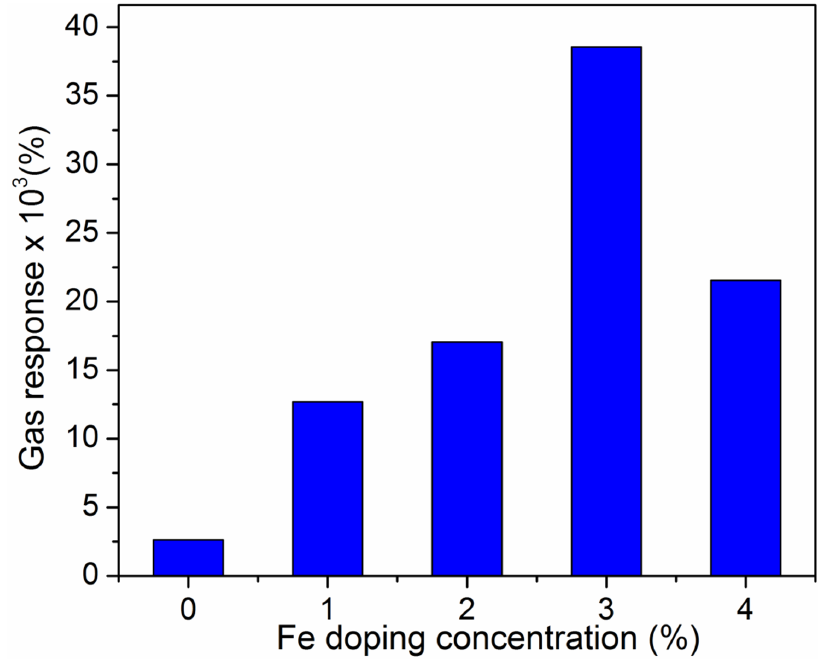
Figure 7. Gas response of Fe doped MoO 3 thin films. Table 2. Gas sensing parameters of Fe doped MoO 3 thin films with different Fe doping concentrations.